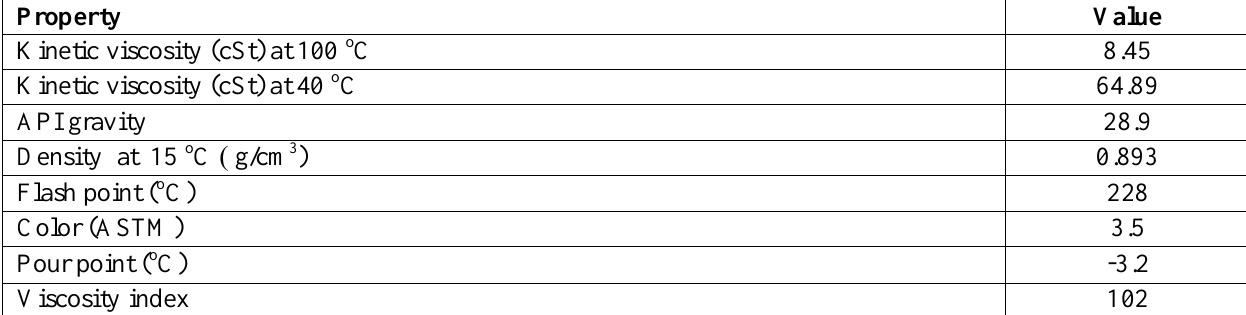
Table 1: The general specification of the base lube oil (stock